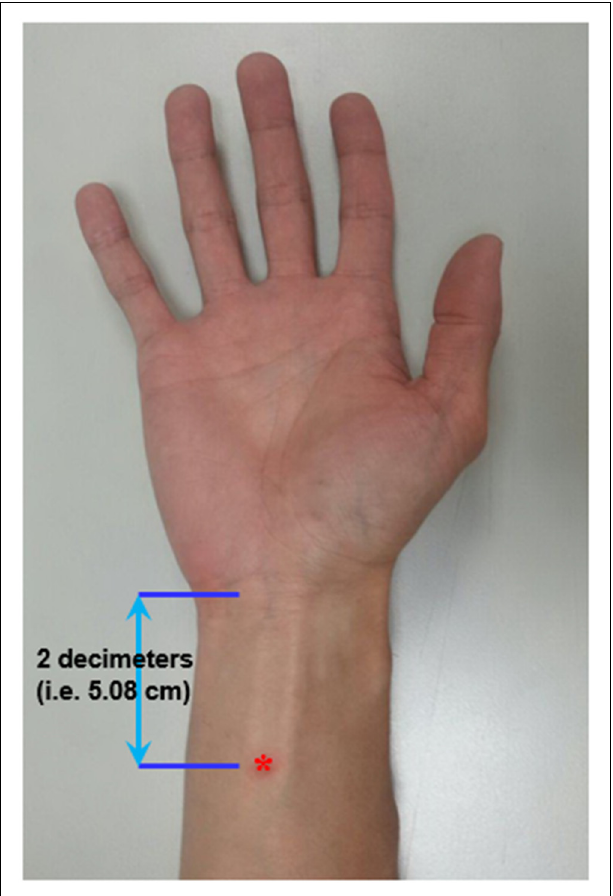
FIGURE 1 | Localization of the acupoint “Neiguan” (Pericardium 6, PC6; ∗